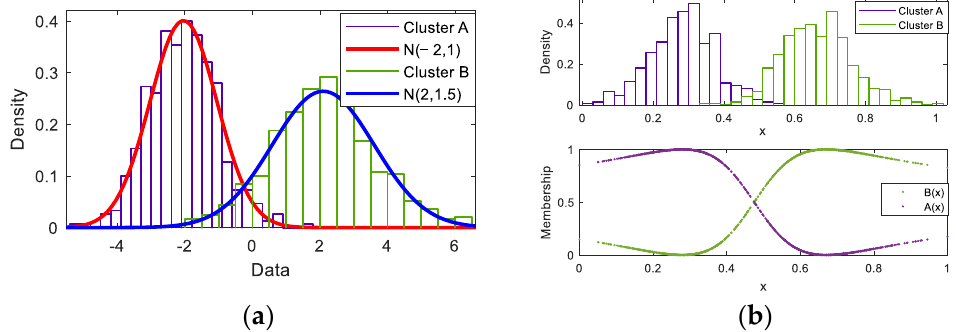
Figure 3. Distribution of one-dimensional synthetic data. ( a ) Original distribution; ( b ) FCM clustering and membership